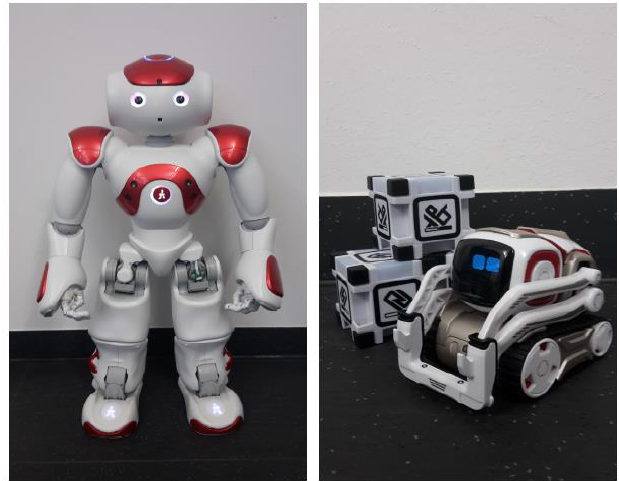
Fig. 6. Aldebaran Robotics’ NAO (left) and Anki’s Cozmo